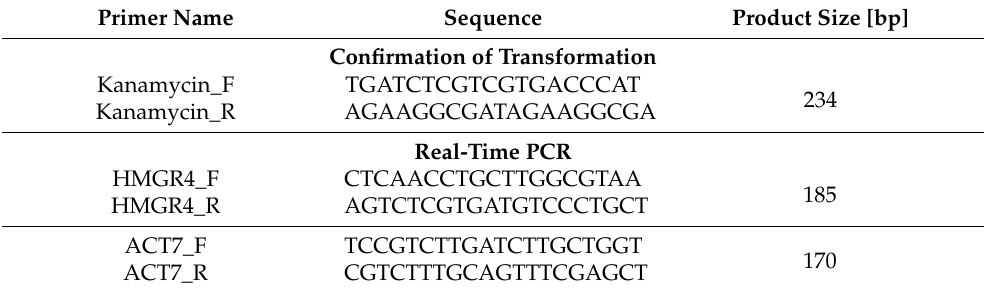
Figure 3. Map of the expression construct pRI201-AN-HMGR4. Table 2. Primers used in the